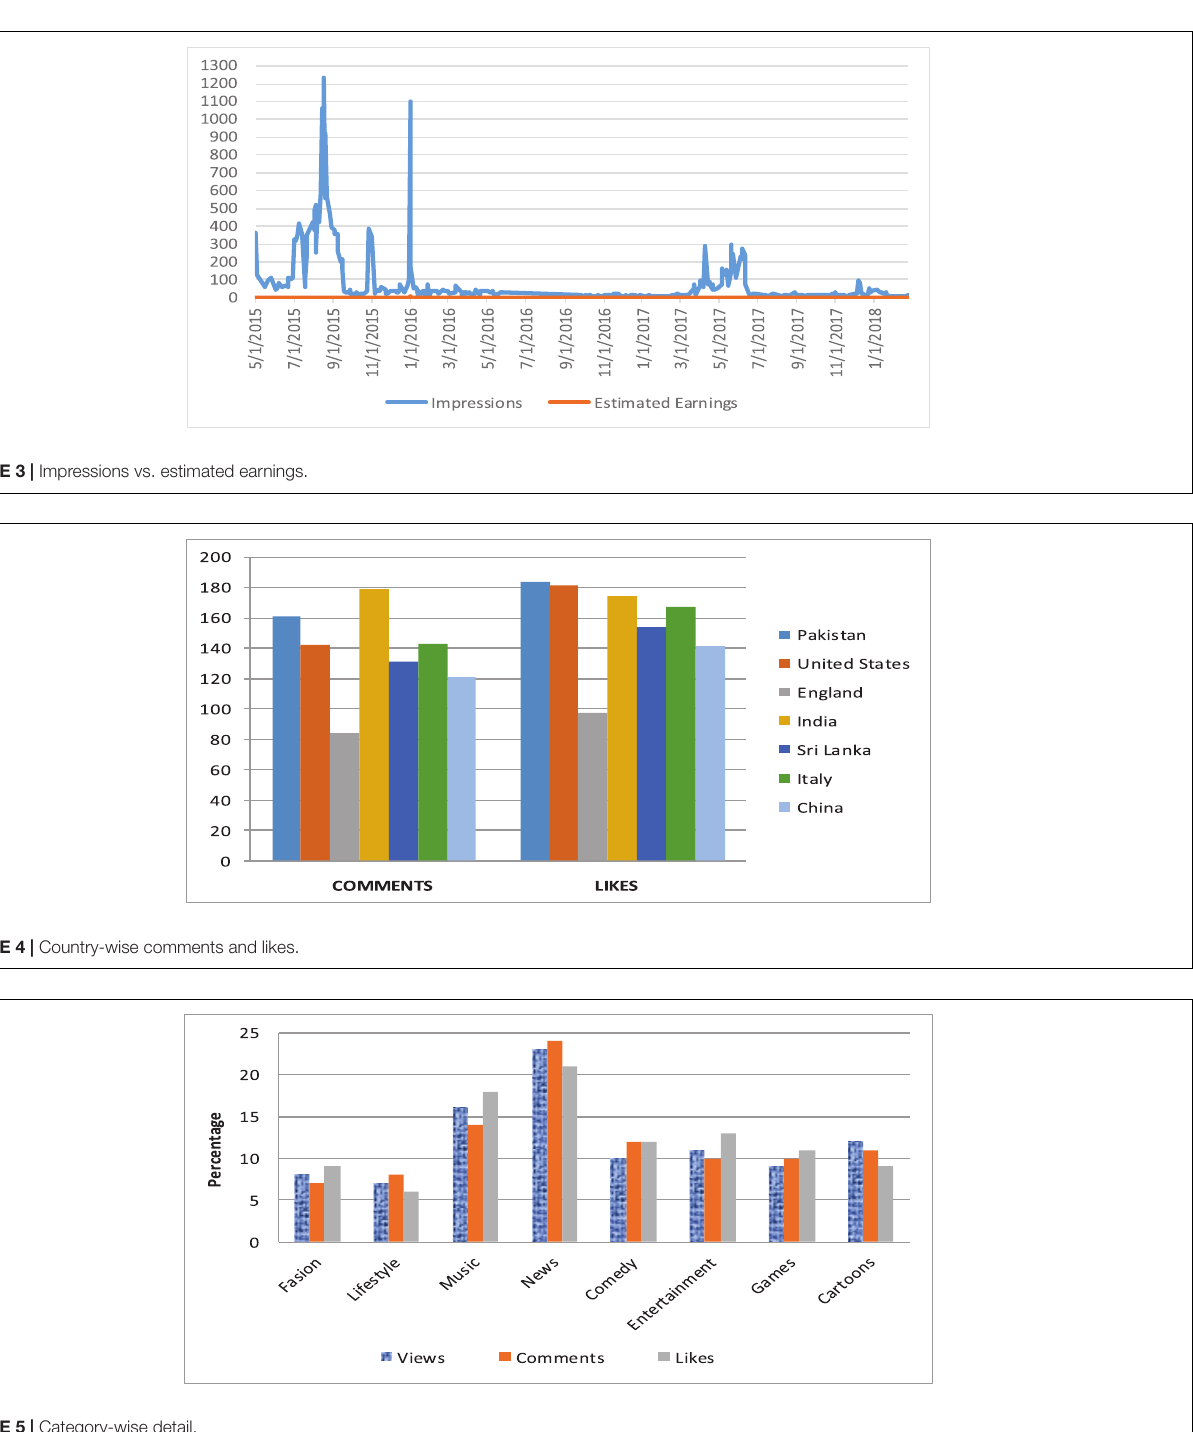
FIGURE 5 | Category-wise